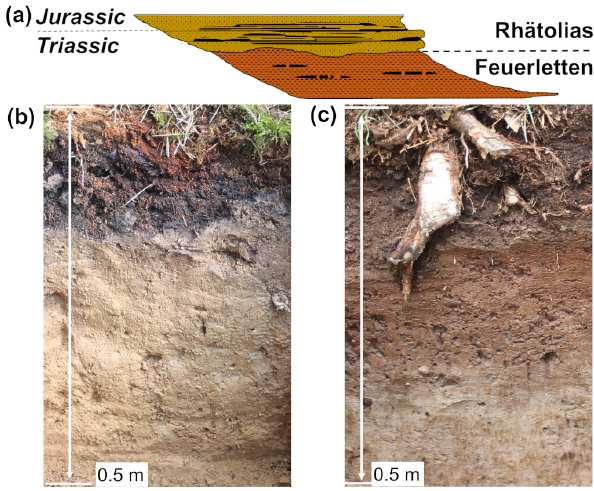
Figure 1. (a) 2D slope profile with the major geological units in the Franconian Jura. Soil pits showing the upper 0.5m of soil developed in (b) Rhätolias sandstone and (c) Feuerletten